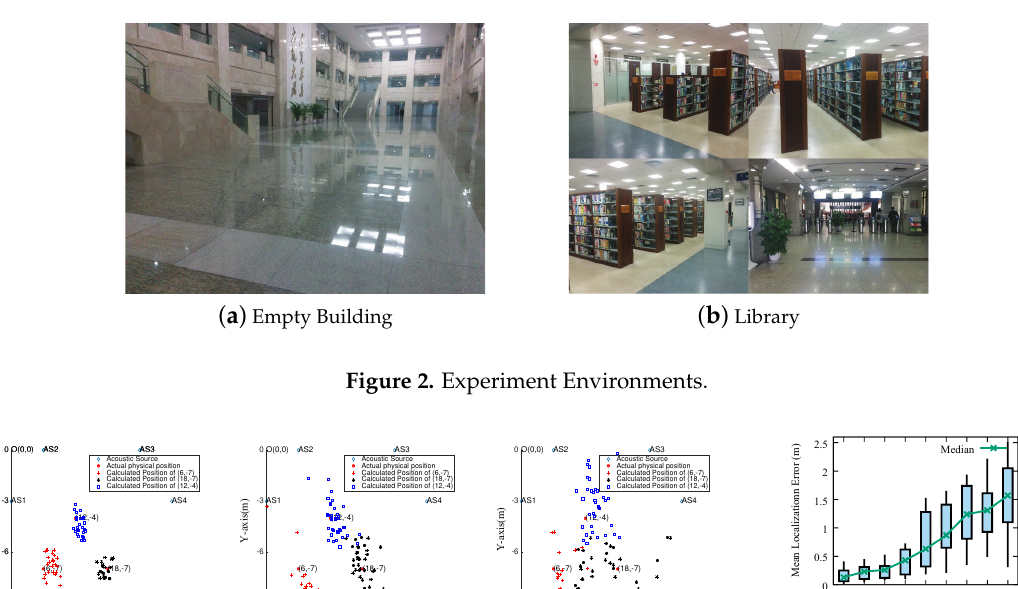
as diamonds in the figure. The coordinates of located locations at (6, − 7), (18, − 7) and (12, − 4) are marked as red solid circles.